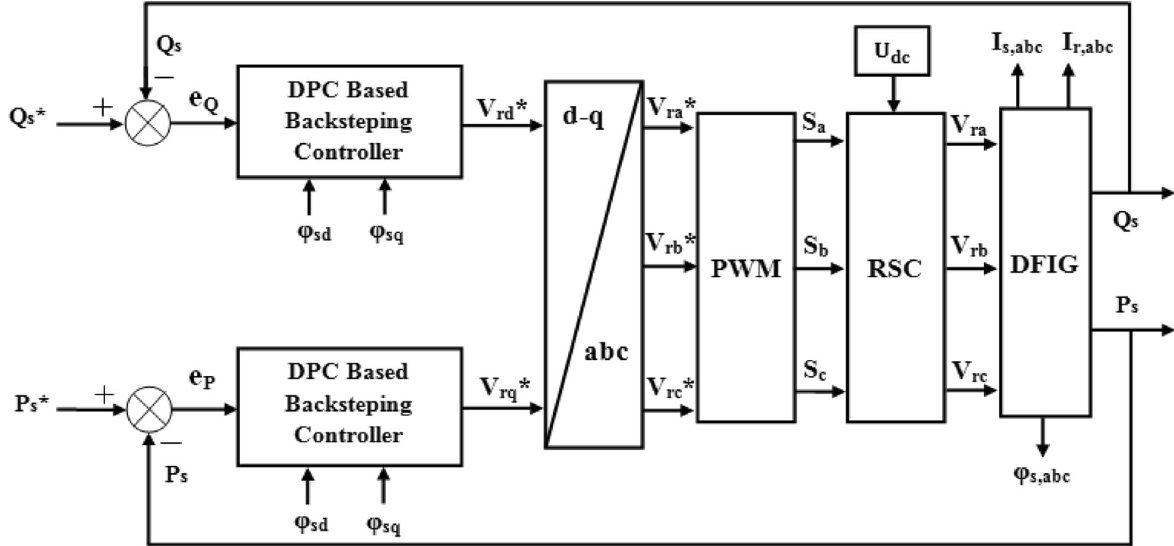
Fig. 3 The proposed DPC bloc diagram using the Backstepping